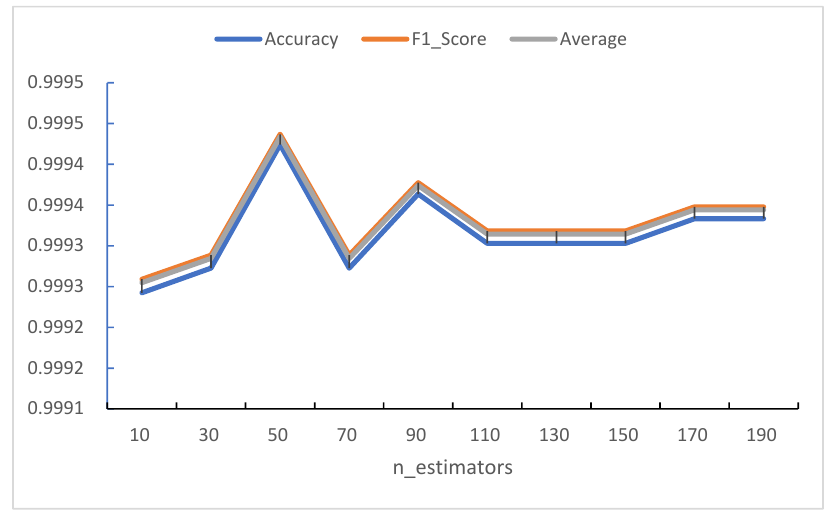
Figure 17. n_estimators optimize Accuracy, F1_Score, and Average.